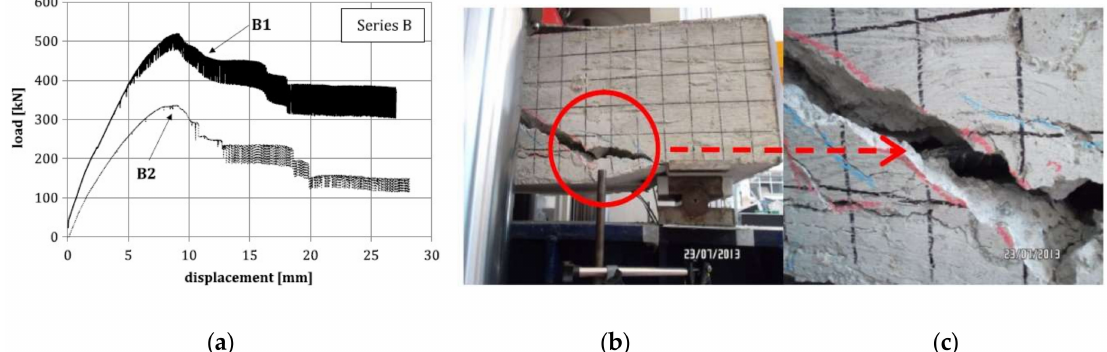
Figure 20. Series B: ( a ) load-deflection curves; ( b ) main diagonal crack at the support (spec. B2); ( c ) detail of the dowel mechanism (spec